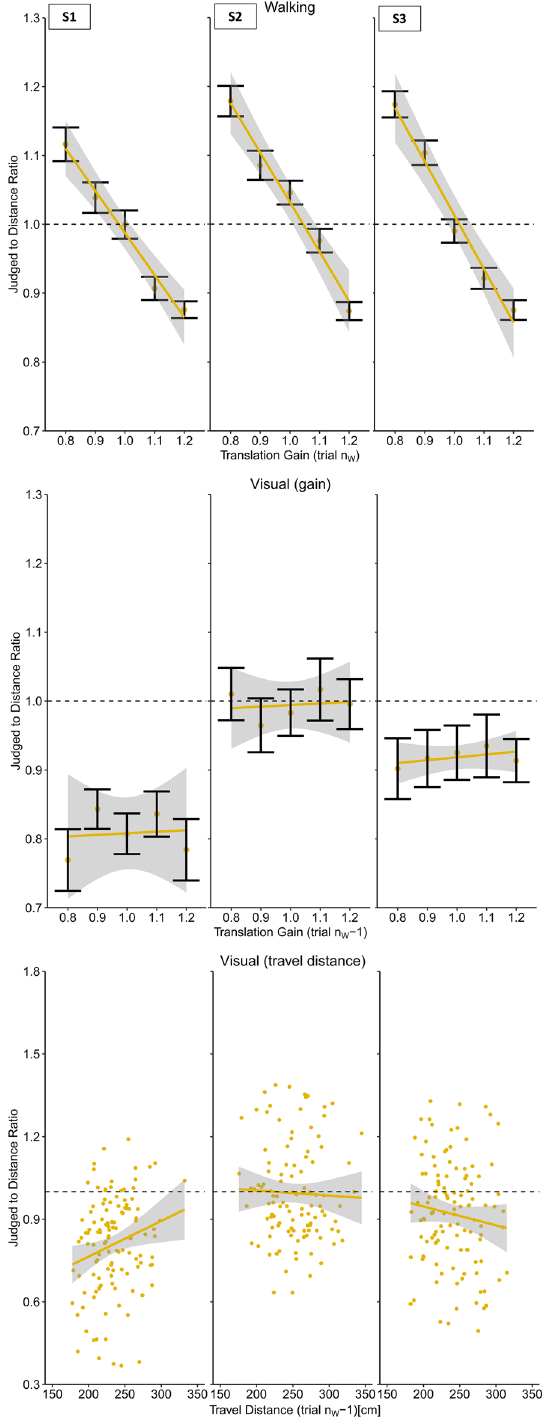
Figure 4. Results of Experiment 2 (artificial walking with optic flow) for three example participants. Upper panel: Regression between the translation gain in trial n W and judge to distance ratio for walking distance estimations in trial n W . Middle panel: Serial dependencies quantified by the regression between the translation gain in in trial n w − 1 and visual distance judgements. Lower panel: Serial dependencies quantified by the regression between travel distance in trial n w − 1 and visual distance judgements. Error bars represent the SEM and the grey areas represent the 95% confidence